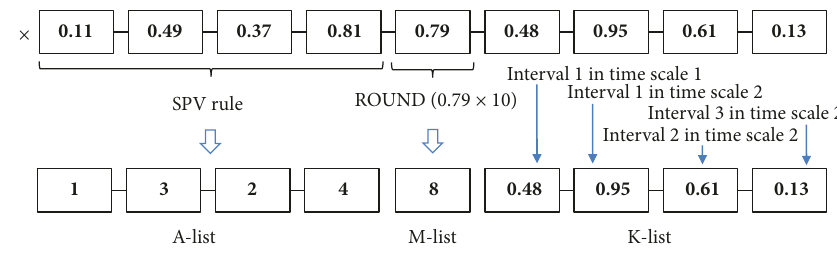
Figure 4: Example of converting a particle into